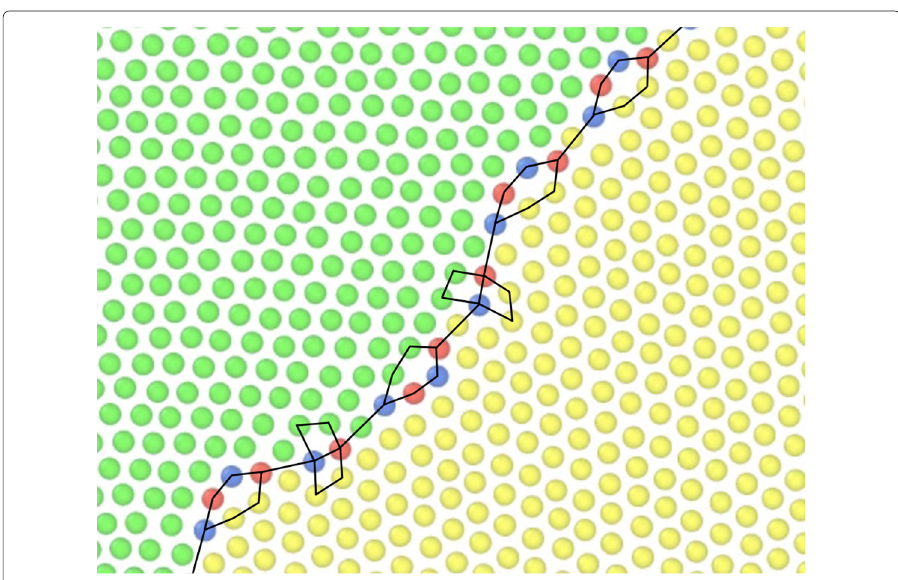
Fig. 12 Structure of a high angle grain boundary described in terms of structural units for θ 0 = 21.8 ◦ . Red and blue atoms have 5 and 7 NN, respectively